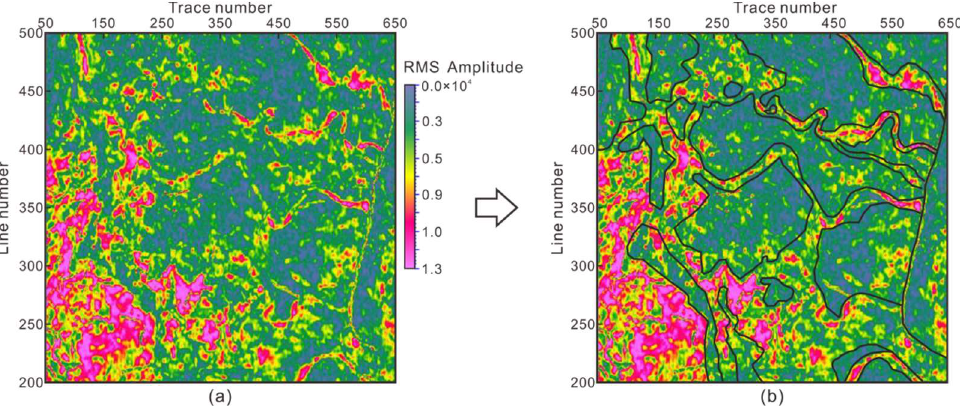
Figure 7. Sedimentary characteristics of the interface at the bottom of the Sifangtai formation. ( a ) The seismic attribute of RMS amplitude, ( b ) The division of sedimentary facies.